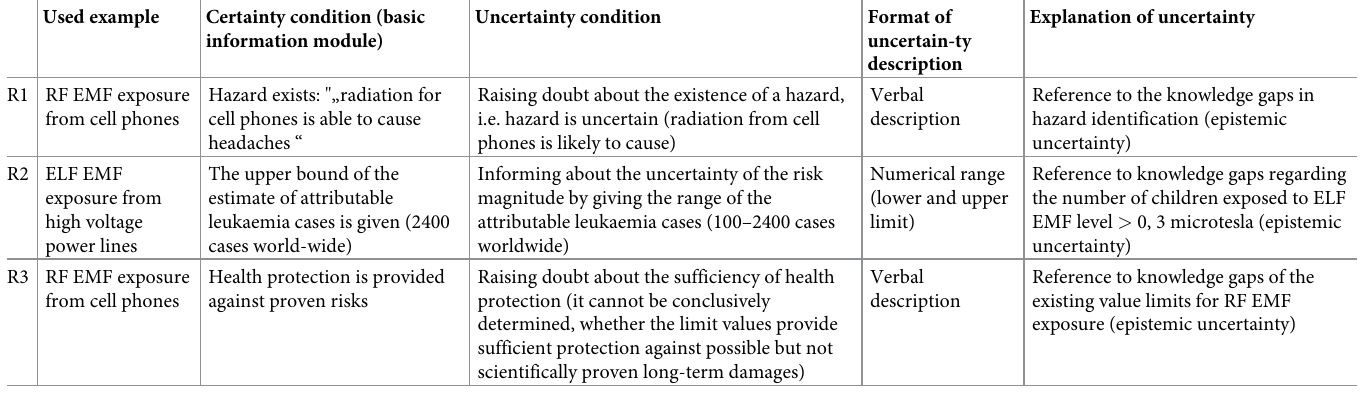
Table 1. Main features of the experimental